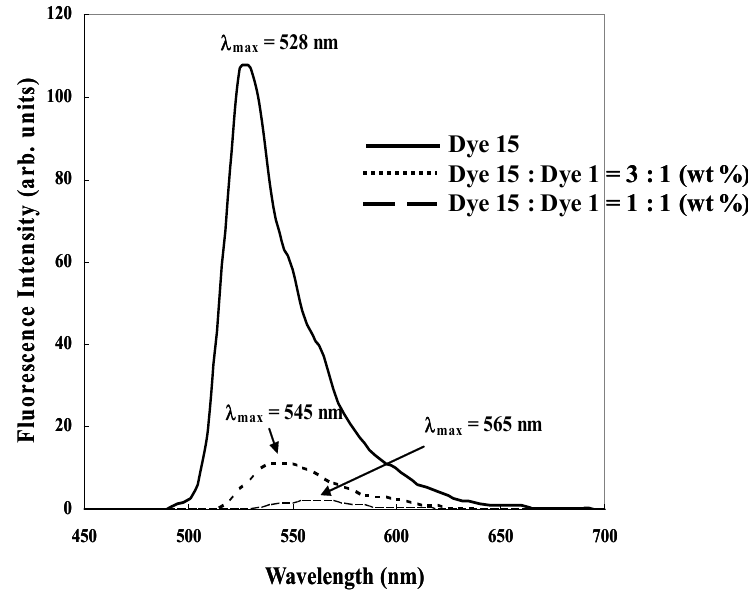
Figure 11. The fluorescence spectra of the mixtures of anthraquinone dye 1 and coumarin dye 15